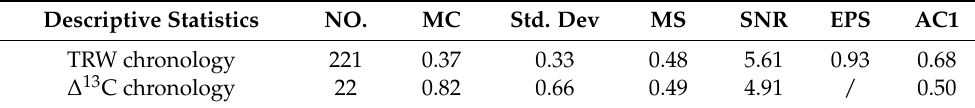
Table 2. Descriptive statistics for the composite TRW chronology and ∆ 13 C